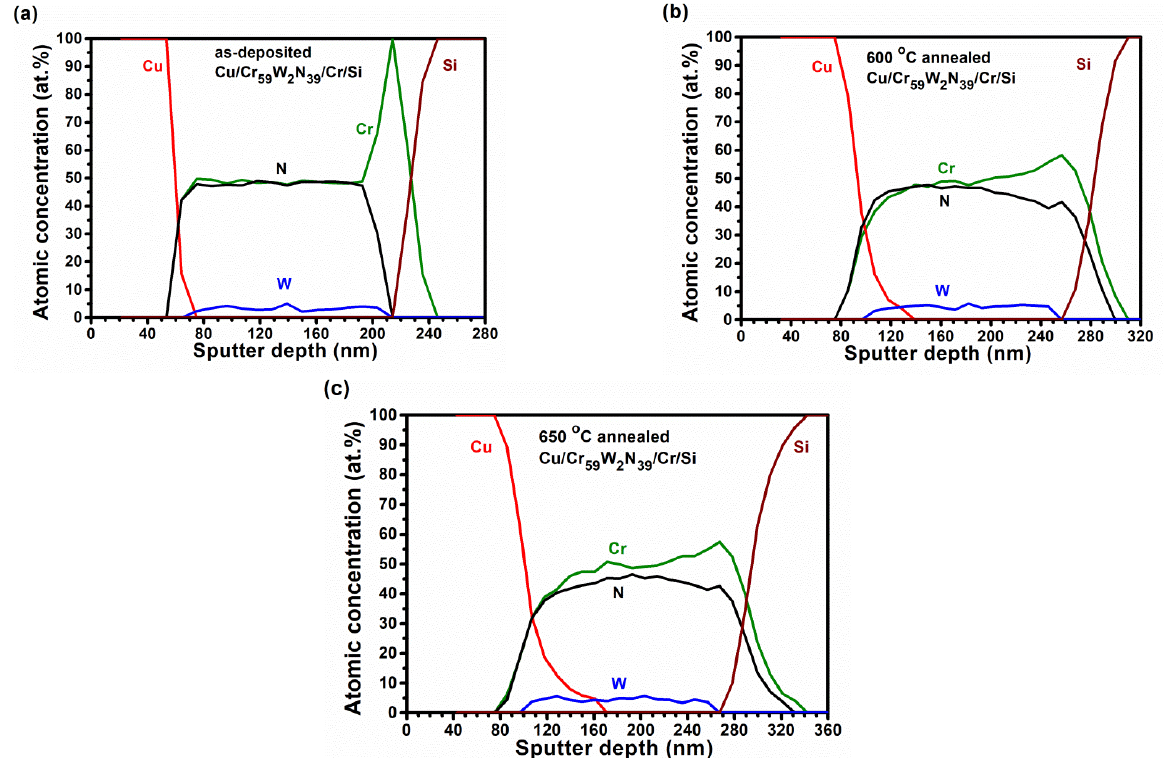
Figure 14. AES depth profiles of ( a ) as-deposited, ( b ) 600 °C, and ( c ) 650 °C annealed Cu/Cr 59 W 2 N 39 /Cr/Si samples. (Annealed in vacuum for 1 h).